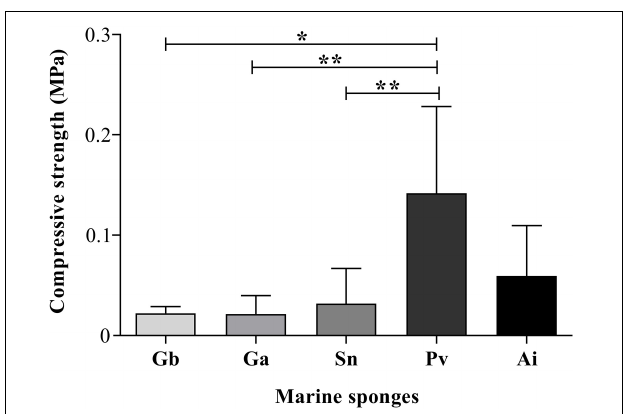
FIGURE 9 | Determination of structural composition of marine sponge of the Geodia barretti (Gb), Geodia atlantica (Ga), Stelletta normani (Sn), Phakellia ventilabrum (Pv), and Axinella infundibuliformis (Ai). Data expressed as mean of three replicates per sponge species and non-statistically significant differences ( p < 0.05) after Kruskal–Wallis test with Dunn’s multiple comparisons.